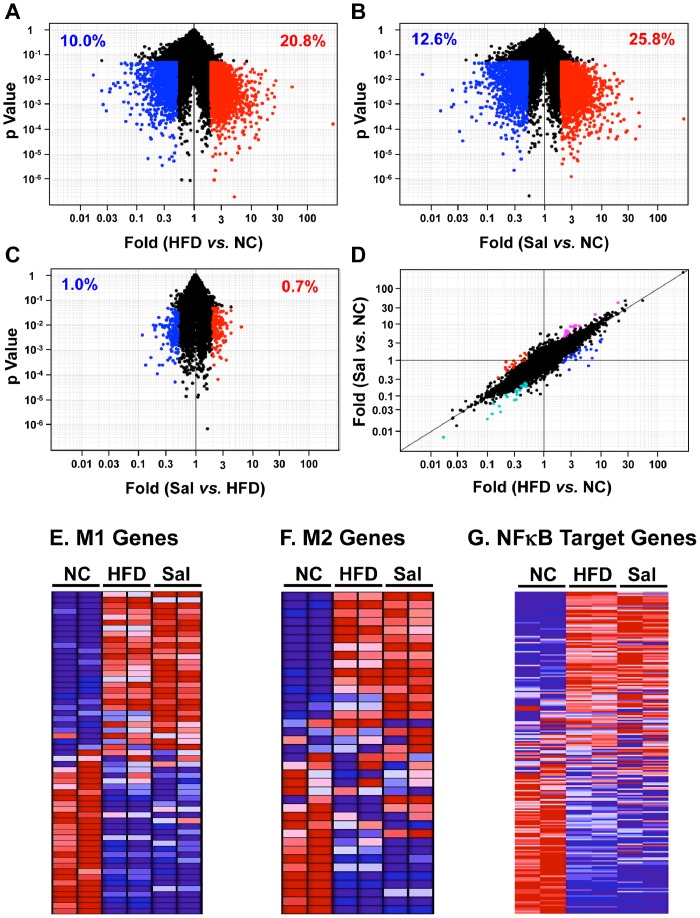
Microarray analysis of sorted ATMs from the NC, HFD and Sal groups.The ATMs were isolated from the ATs of the NC, HFD and Sal groups of the treatment study (n = 2 mice per group). Their RNAs were purified, amplified and analyzed by Affymetrix microarray analysis. The HFD vs. NC (A), Sal vs. NC (B), and Sal vs. HFD (C) gene expression profiles were compared by Volcano plots. Genes showing more than 2-fold differences between groups that were significant (p<0.05) are indicated as red dots if they were upregulated and as blue dots if they were downregulated genes. The genes in HFD and Sal mice that were differentially regulated relative to NC are shown in a FC/FC plot of (HFD vs. NC) vs. (Sal vs. NC) (D). The genes that showed a more than 2-fold difference in this comparison that was significant (p<0.05) are indicated as red dots (HFD down and Sal up), blue dots (HFD up and Sal down), cyan dots (HFD down and Sal further down), and pink dots (HFD up and Sal further up) (see Table 2). Heat maps show the differential gene expressions of M1 genes (E), M2 genes (F) and NFκB target genes (G).